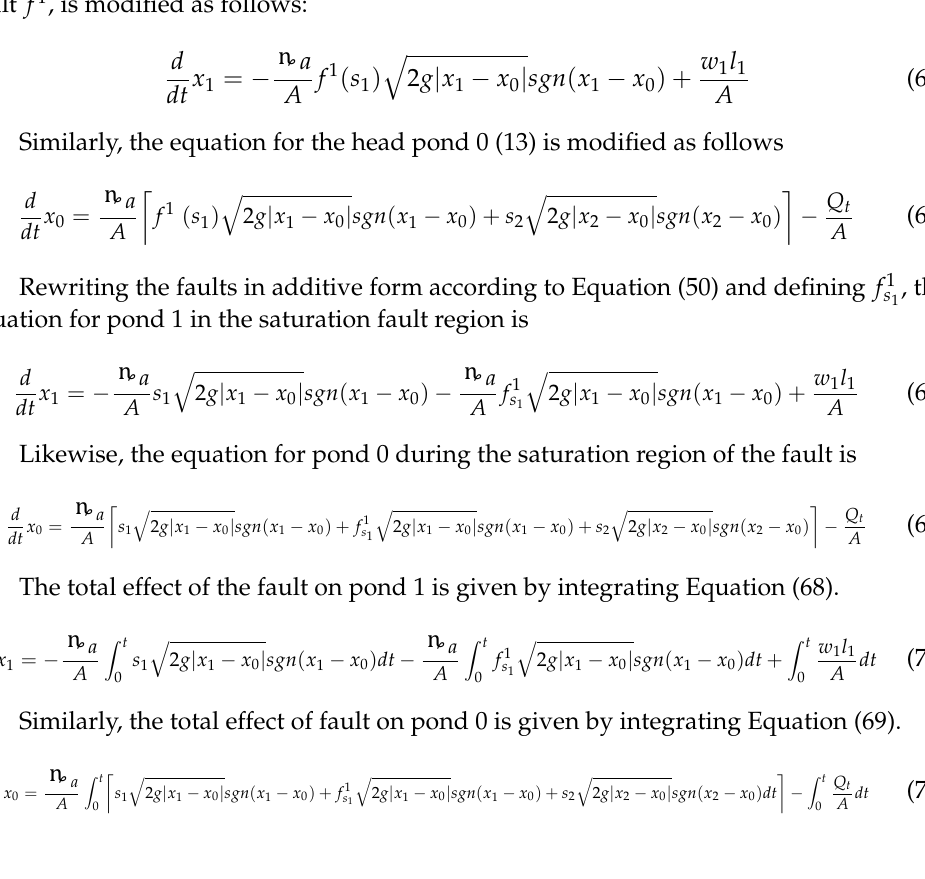
Figure 1. Three-pond hydraulic system.